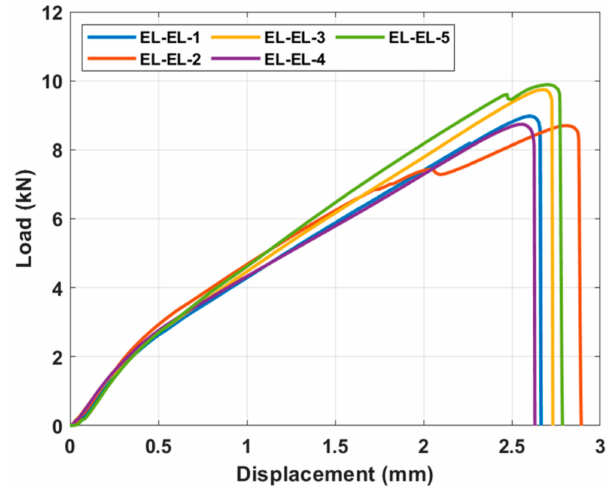
Figure 9. Load vs. displacement curves for the adhesively bonded Elium ® composites.